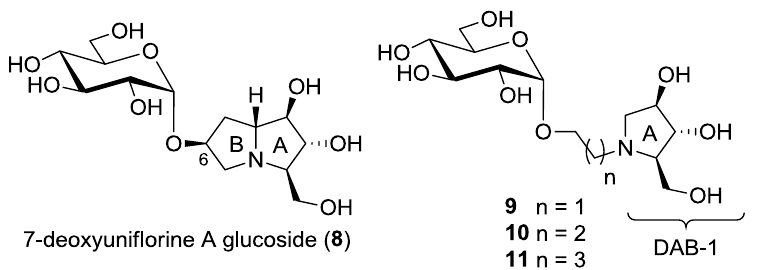
Figure 2. This work: synthesis of a new pseudodisaccharide mimetic 8 and of a series of more flexible disaccharide mimics 9 – 11 bearing the DAB-1 nucleus instead of the pyrrolizidine moiety.